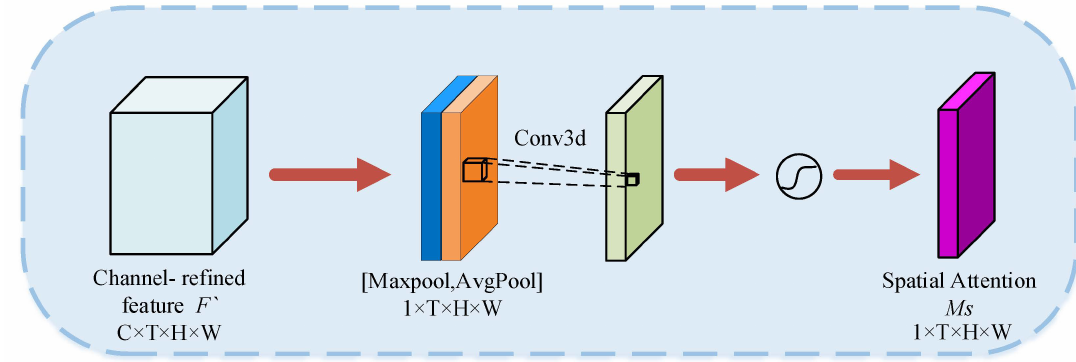
Figure 9. Spatial Attention Module.